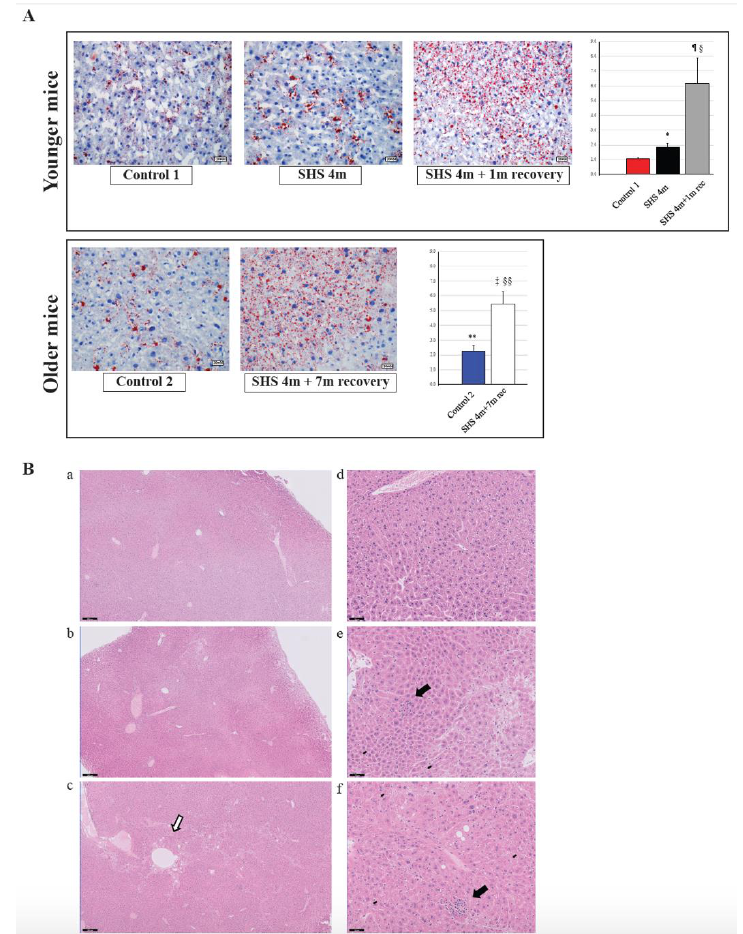
Figure 4. Evaluation of fat accumulation and liver injury in SHS-exposed mice. ( A ) Liver sections from SHS-exposed and control mice were stained with Oil Red O to detect neutral lipid accumulation (red droplets) within the hepatocytes. Microphotographs are shown at 400× original magnifications. Quantification of lipid droplets (graphs on the right) was performed on Oil Red O (ORO)-stained slides ( n = 4–8) at 400X magnification by measuring the area occupied by red pixels in ImageJ software (https://imagej.nih.gov/ij/). * SHS 4m vs. Control 1: p = 0.000334; ¶ SHS 4m+1m recovery vs. Control 1: p = 0.000276; § SHS 4m+1m recovery vs. SHS 4m : p = 0.000017; ‡ SHS 4m+7m recovery vs. Control 2: p = 0.000114; §§ SHS 4m+7m recovery vs. SHS 4m : p < 0.00001; ** Control 2 vs. Control 1: p = 0.000508. ( B ) Paraffin-embedded liver sections from experimental and control mice were stained with hematoxylin and eosin (H&E) to examine cell morphology and detect potential manifestations of liver injury. Representative microphotographs are shown at low (scale bar, 200 µ M) and high magnifications (scale bar, 50 µ M). Top panels ( a , d ), control mice; middle panels ( b , e ), SHS 4m mice; lower panels ( c , f ); SHS 4m + 1m recovery mice. Small foci of inflammatory infiltrates and areas of necrosis were observed in the liver of SHS 4m and SHS 4m + 1m recovery mice (panels e , f ). SHS 4m + 1m recovery mice exhibited a disrupted cord-like architecture and a great variability in the size and nuclear morphology of hepatocytes (panel f ). The white arrow shows an area of pronounced liver steatosis. Big black arrows, foci of inflammation; small black arrows, apoptotic